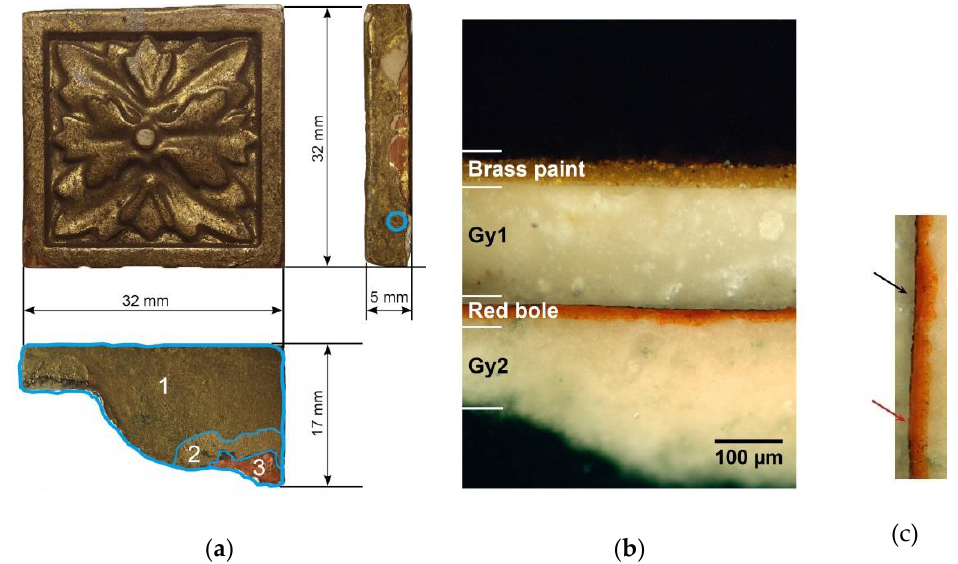
Figure 1. ( a ) Original frame ornament; ( b ) cross-section microphotograph (bright field with crossed Nicols) of the circled area in Figure ( a ); ( c ) detail of the red bole and gold leaf interface of Figure ( b ): the gold leaf (black arrow) in some points is completely lost (red arrow) .